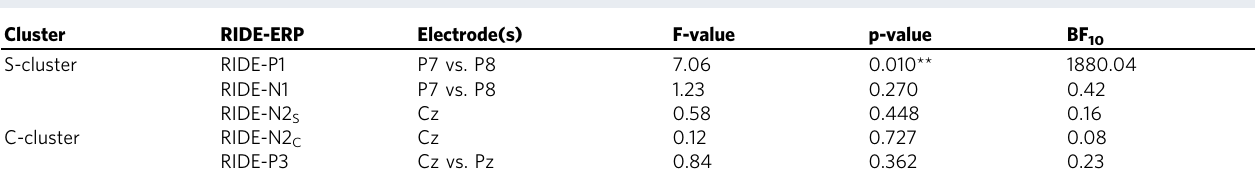
Fig. 3 Event-related components in the RIDE S- and C-cluster. RIDE data of N = 78 participants in a the RIDE S-cluster (P1 and N1 pooled across electrodes P7 and P8, N2 S on electrode Cz), and b the RIDE C-cluster (N2 C on electrode Cz, P3 pooled across electrodes Cz and Pz). The lines for the placebo session are shown in blue, the lines for the MPH session are shown in orange. The non-overlapping condition is shown in a lighter color than the overlapping condition. Time point 0 denotes the time point of the stimulus onset. Topographic plots show the distribution of the potentials at the peak of the respective component. Positive potentials are shown in red, negative potentials are shown in blue, scaling is given in μ V/m². Table 1 Interaction effect